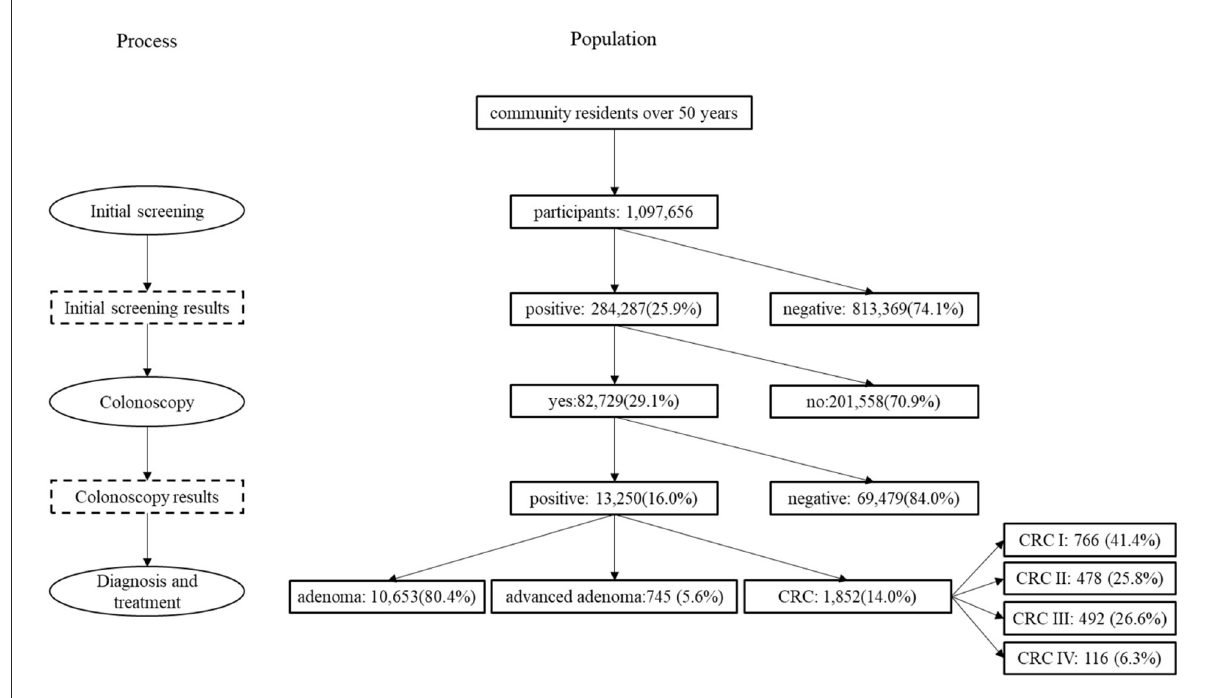
FIGURE1 Process of 2014–2016